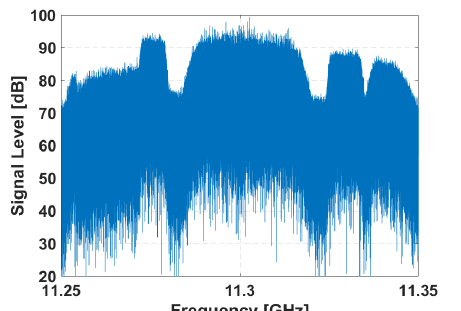
Figure 14. Spectrum of the signal acquired by the reference channel in one of the measurements of the trials.